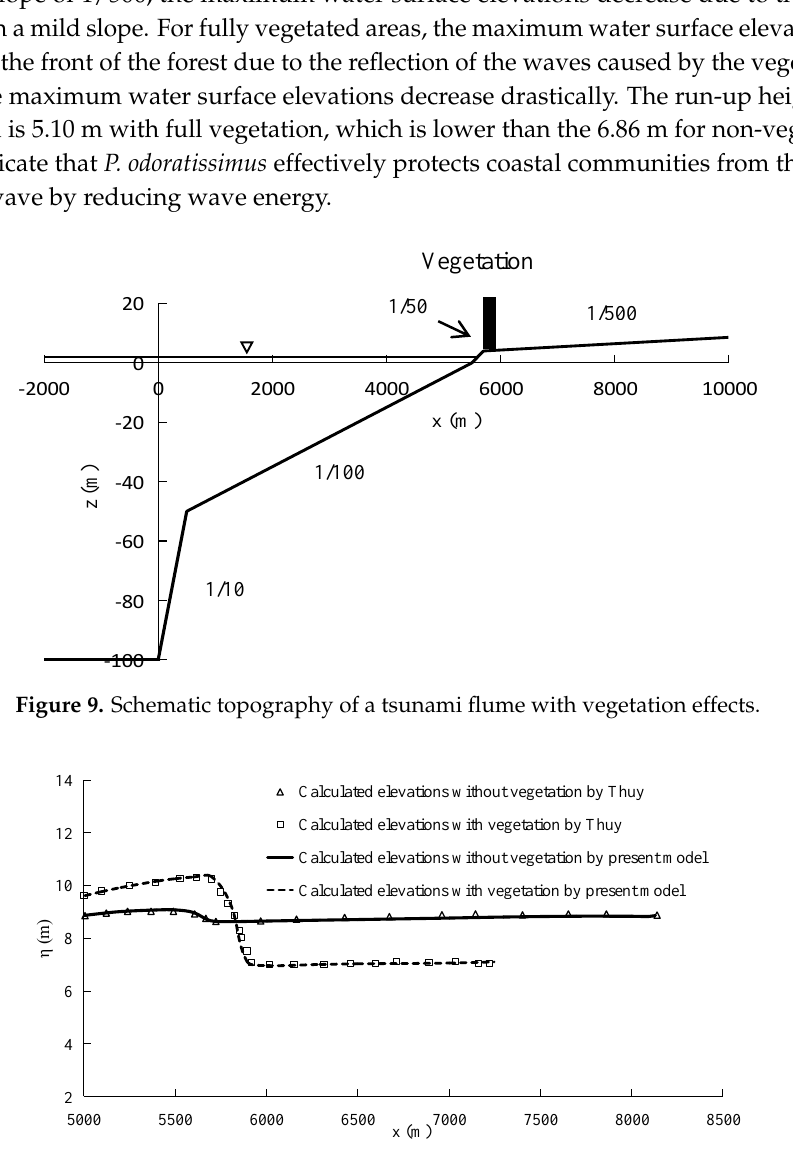
Figure 10. Maximum water surface elevations of the first wave without vegetation and with P. odoratissimus vegetation [26].